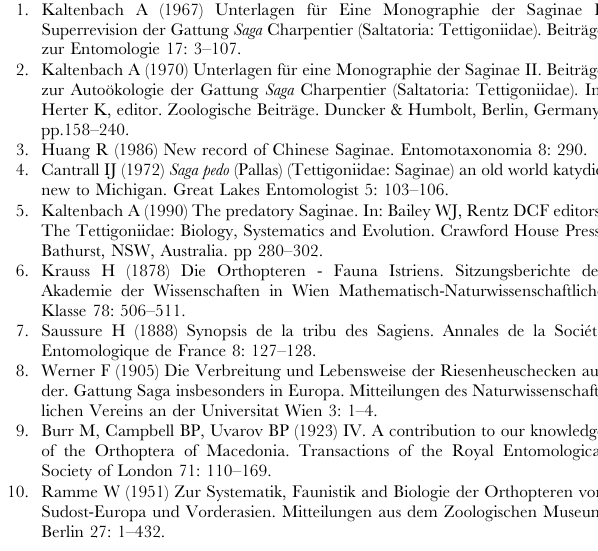
Figure S5 Oscillographic pattern of the calling song of the two problematic subspecies. A)A sequence of three echemes of S. c. campbelli (recorded at 26.7 u C); B)A sequence of two echemes of S. c. gracilis (recorded at 26.3 u ); C) One echeme of S. c. campbelli at a higher time resolution (the second one from oscillogram A); one echeme of S. c. gracilis at a higher time resolution (the first echeme in oscillogram B in this figure). Table S1 Primers used for the phylogenetic analysis. Table S2 Acoustic data used in PCA analysis. Table S3 Morphometric data used in PCA analysis. Table S4 Inter-specific variability among Saga pedo clones can be higher (even on the same habitat) than that of its bisexual congeners independently from geographic distance. Table S5 Comparison of the genetic and geographic distances among the Saga species